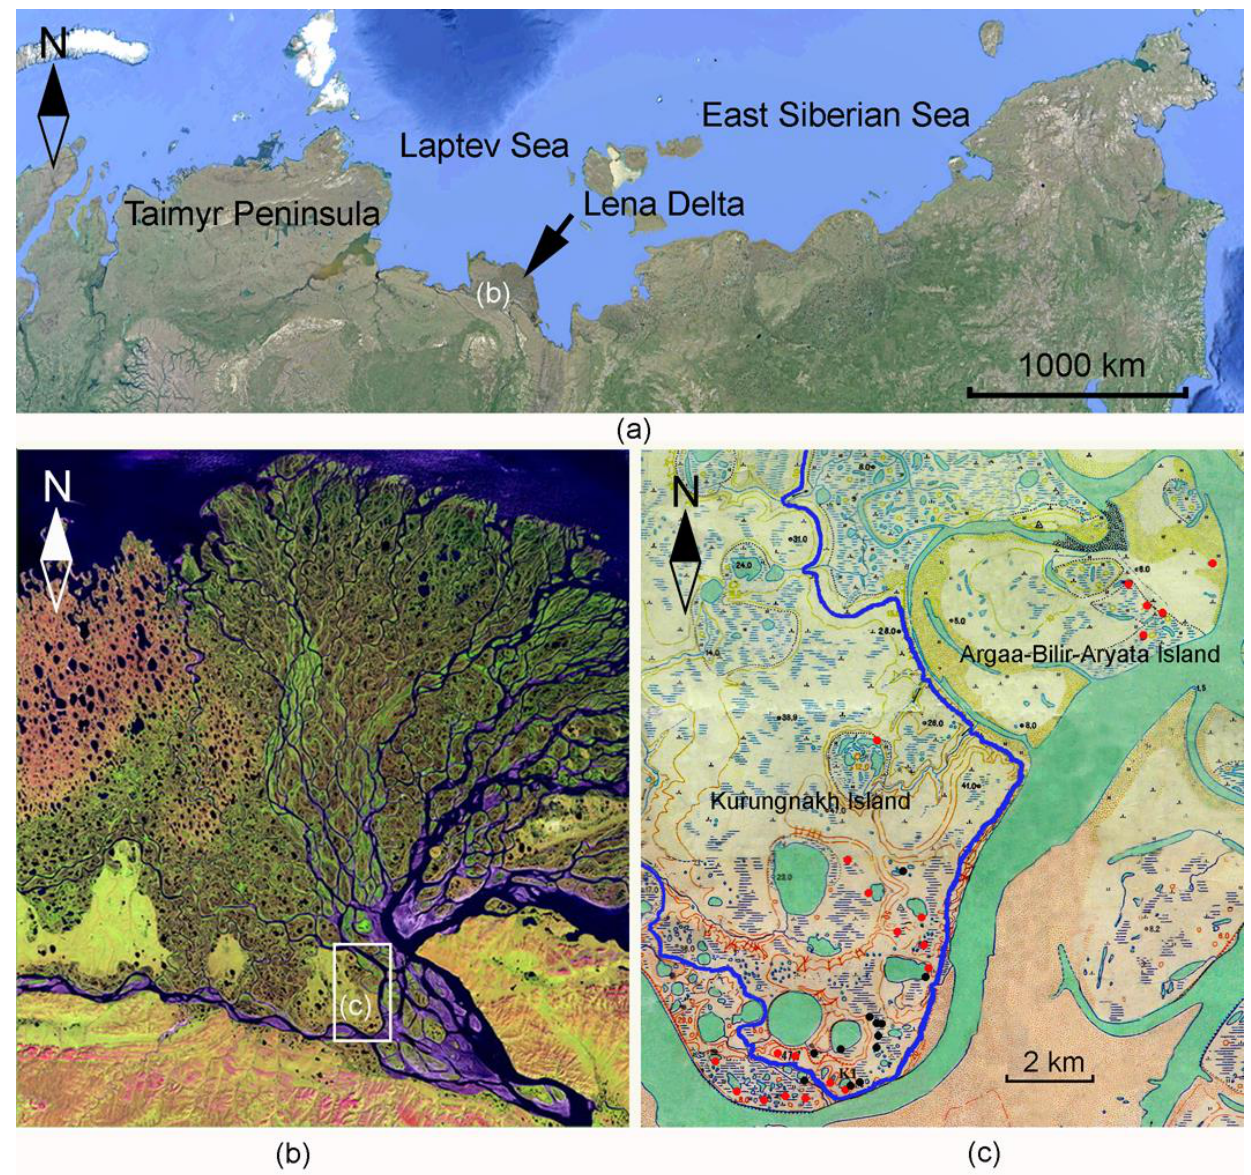
Figure 1. Map of Eastern Siberia ( a ) with position of the Lena Delta (arrow); Lena River Delta ( b ) with location of sampling area (white square); sampling area ( c ) with positions of sampling points (red2017, black2020) and border between first and second river terraces (blue line).